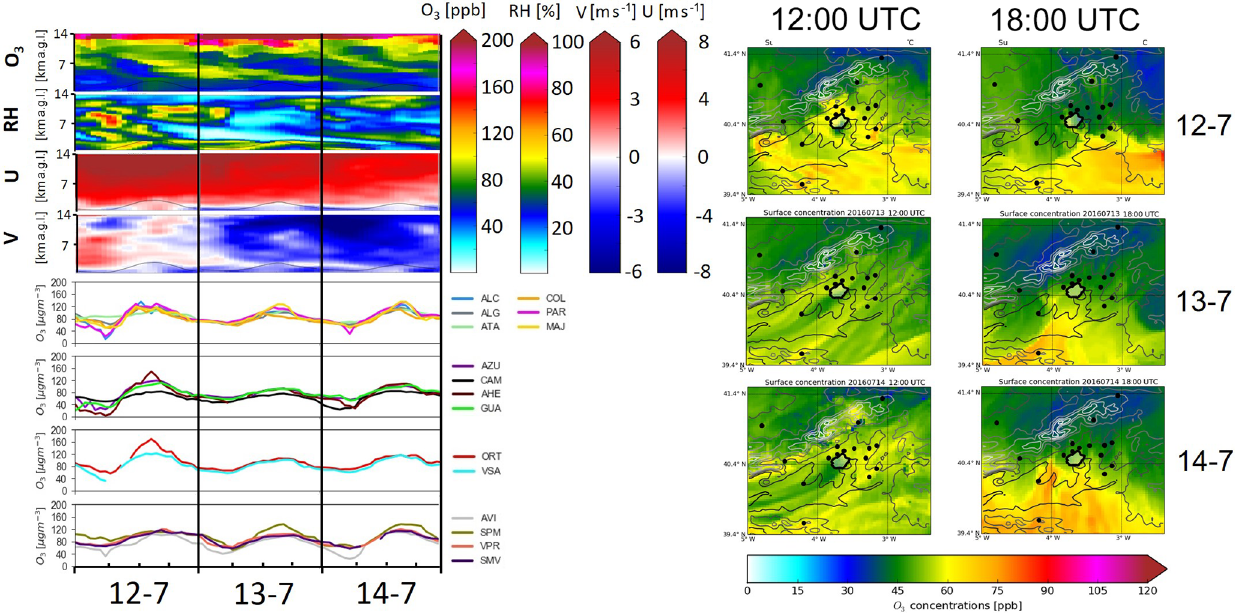
Figure 7. Left: hourly O 3 concentrations recorded at selected monitoring stations in the MAB and simulated fields of O 3 concentration, rela- tive humidity, and U and V components of wind for the period 12–14 July 2016 over the centre of the MAB. Right: surface O 3 concentration maps obtained from LOTOS-EUROS simulations at 12:00 and 18:00UTC of 12, 13 and 14 July 2016 in the MAB. See Fig. 1 to consult the location and typology of the selected